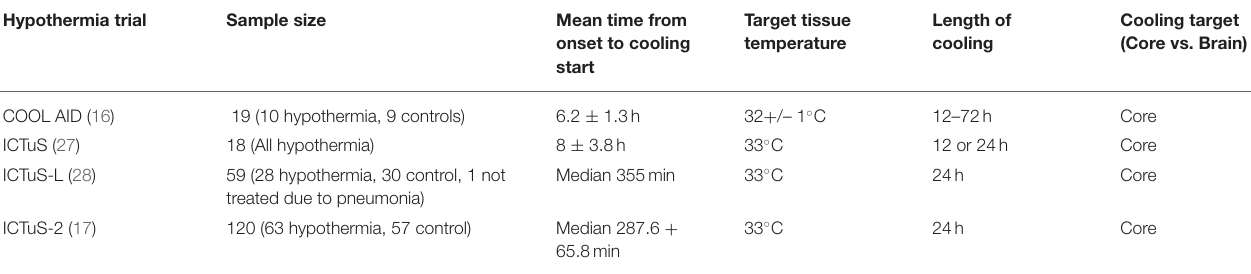
TABLE 1 | Summary of previous hypothermia clinical